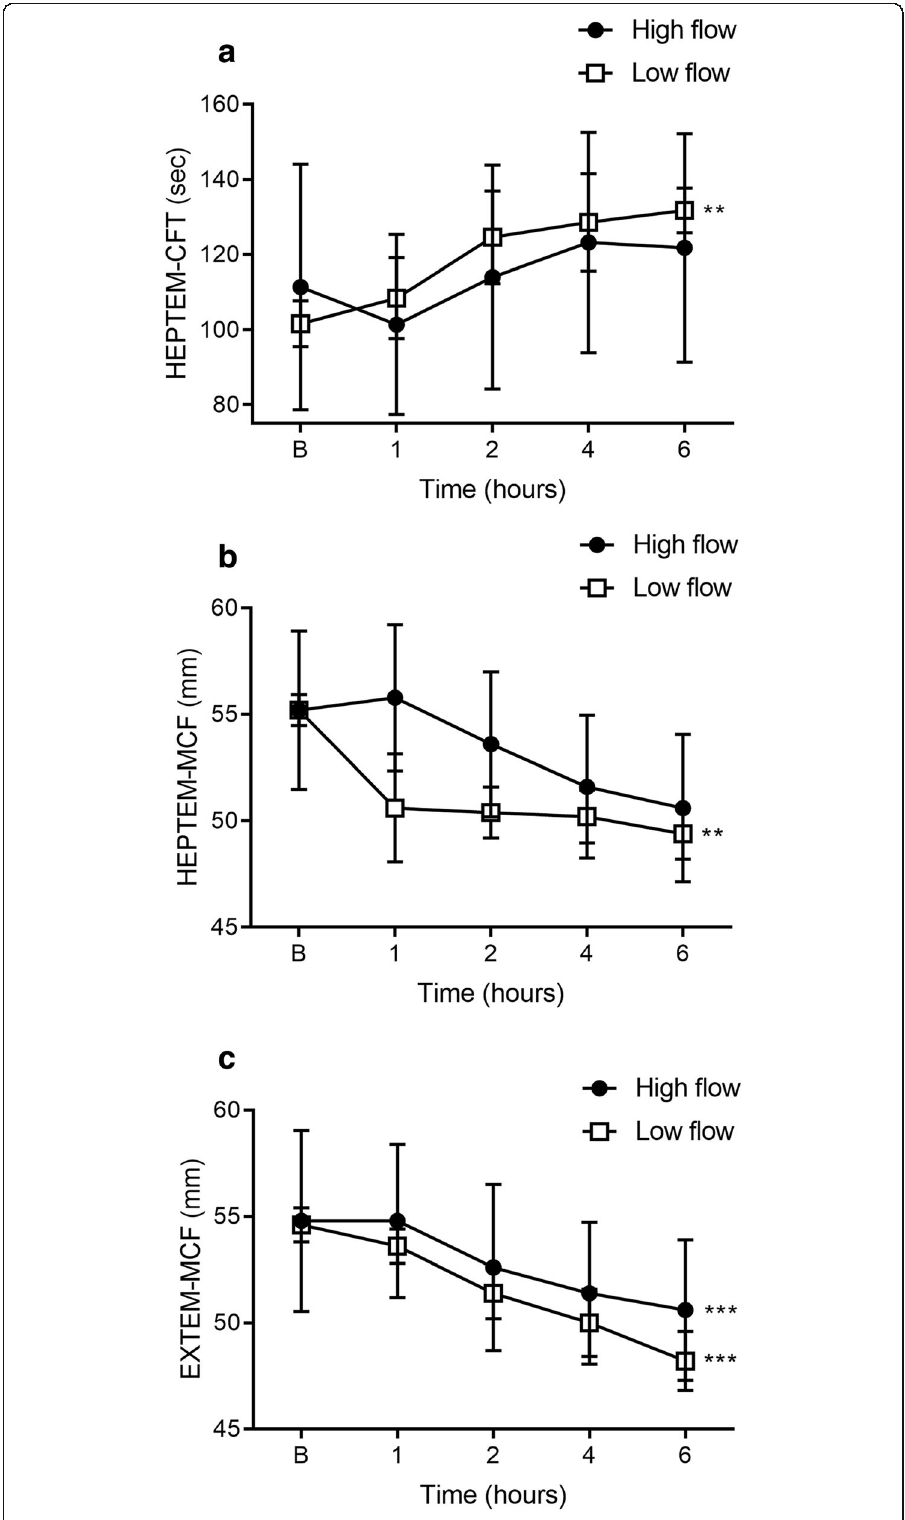
Fig. 6 (See legend on next